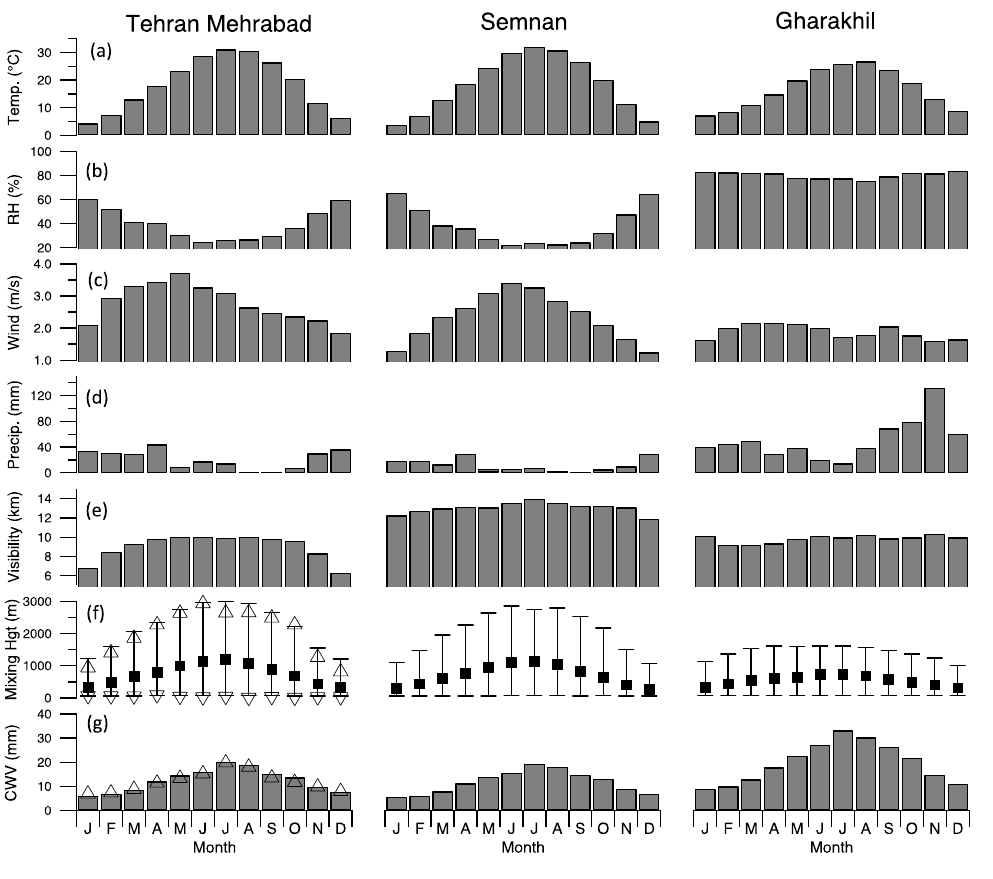
Figure 2. Monthly summary of surface meteorological data at three sites near Tehran (see Figure 1 for locations) between 2000 and 2009 for ( a ) dry bulb temperature (T), ( b ) relative humidity (RH), ( c ) wind speed, ( d ) accumulated precipitation, and ( e ) visibility. Monthly summary of upper air data for the same sites: ( f ) mixed layer height derived from Mehrabad radiosonde data (1980–2012; 00Z and 12Z soundings shown as triangle markers) and MERRA reanalysis data (2000–2009; square markers represent daily mean and whiskers represent average daily range) at grid points near Tehran (35.50°N, 51.33°E), Semnan (35.50°N, 53.33°E) and Gharakhil (36.50°N, 52.67°E); ( g ) Same as (f) except for average total column water vapor